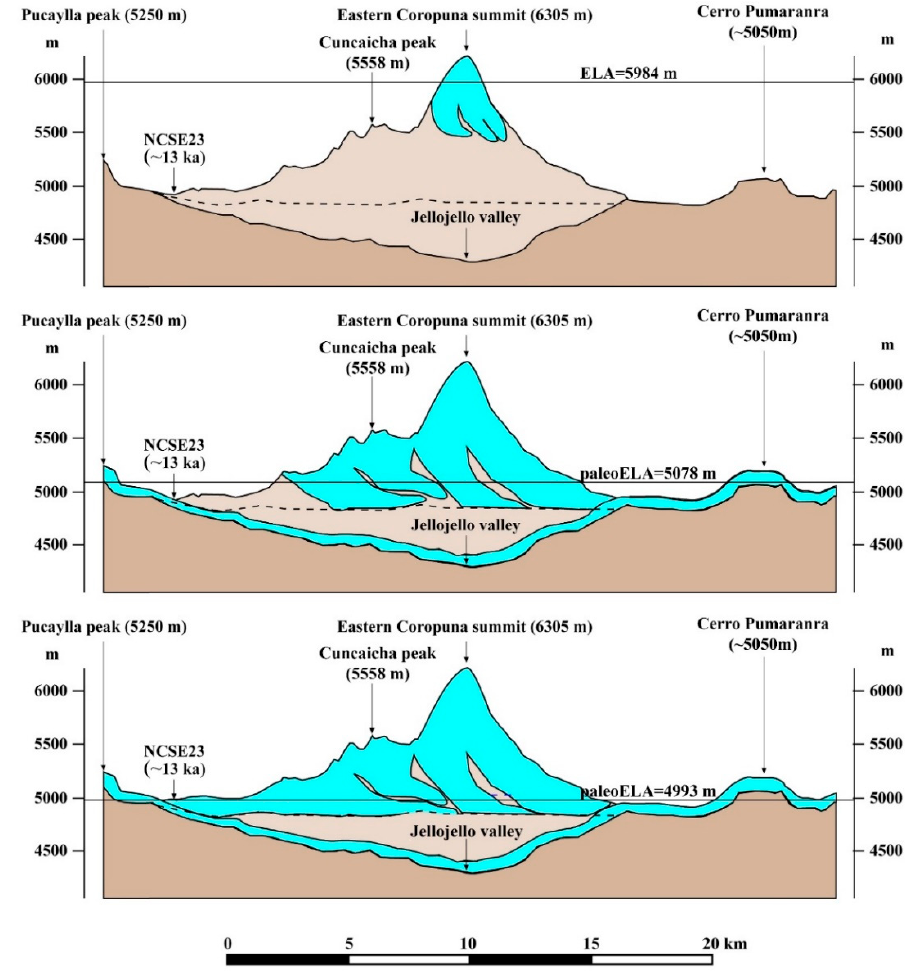
Figure 11. Topographic profiles towards the northeast of Nevado Coropuna, showing the projected glacier extension using ELA 2010 (5984 m, top ); paleoELA 1 (5078 m, center ) and paleoELA 2 (4993 m, bottom ). Because the paleoELA 1 is higher than the NCSE23 surface and lower than the Cerro Pumaranra summit, it is possible that the deglaciation in the Altiplano and the advancement (or glacier stillstand) in the Jellojello Valley happened simultaneously.